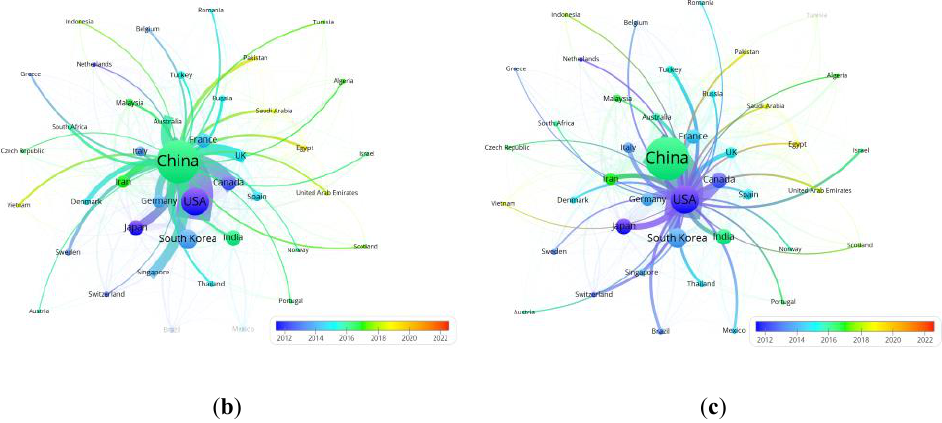
Figure 5. Collaboration network of main countries ( a ) overall collaboration network ( b ) collaboration network with China ( c ) collaboration network with USA.